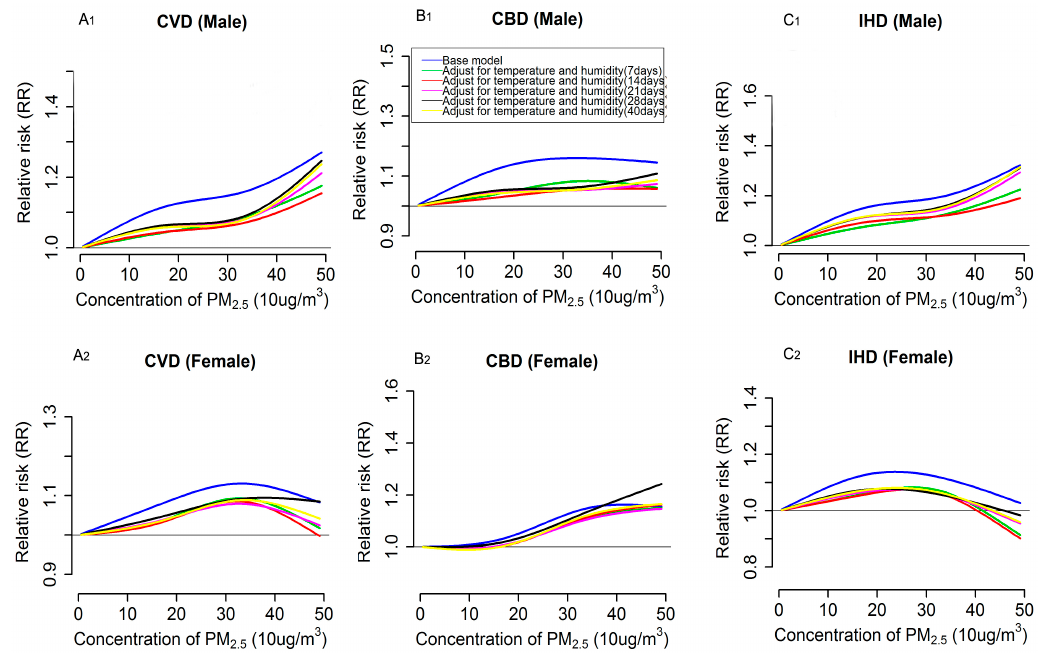
Figure 2. Exposure-response relationships for PM 2.5 (lag 0–1) with cardiovascular (CVD, A 1 , A 2 ), cerebrovascular (CBD, B 1 , B 2 ), and ischemic heart disease (IHD, C 1 , C 2 ) mortality by gender, according to single pollutant UDL models. Values are estimated relative risk of mortality associated with PM 2.5 relatives to lowest value (5.83 µ g/m 3 ). Base model (blue lines) adjusted effects of temperature and humidity only for two days(modeled as two days mean), whereas the lines with color of green, red, pink, black and yellow represent relationships from extensively adjusted models that with simultaneously adjusted cumulative effects of temperature and relative humidity for 7, 14, 21, 28 and 40 days, respectively.